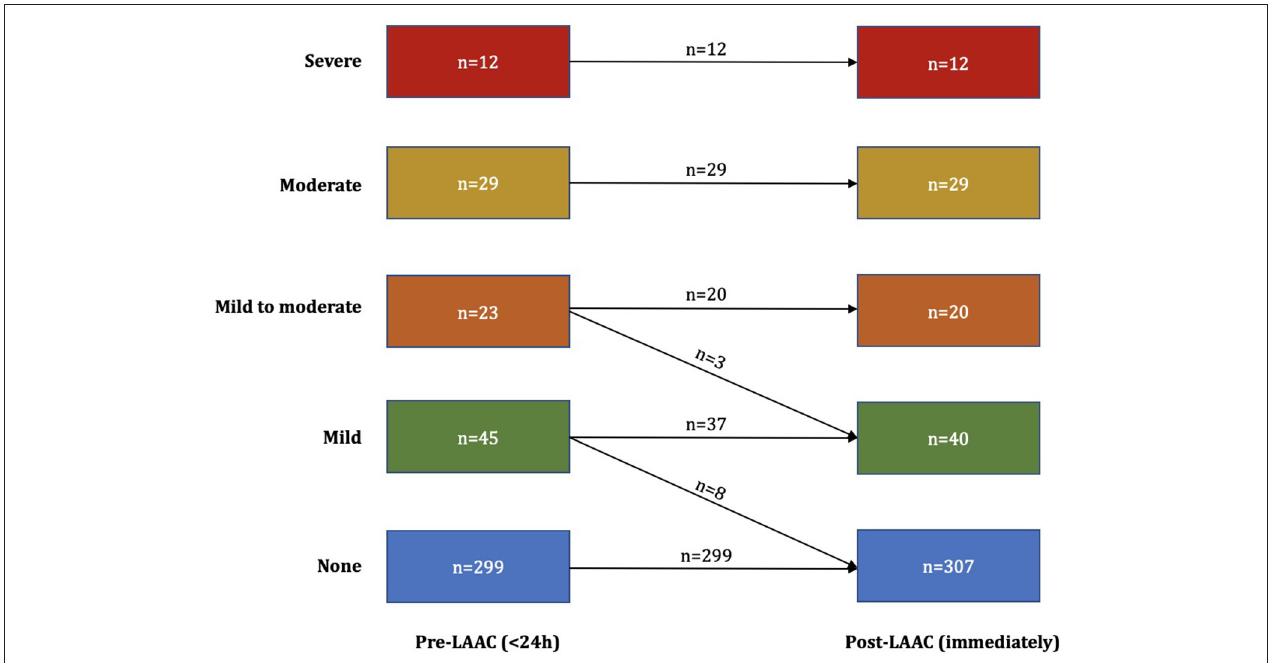
FIGURE 1 | Left atrial spontaneous echo contrast grades before and after left atrial appendage closure (LAAC).